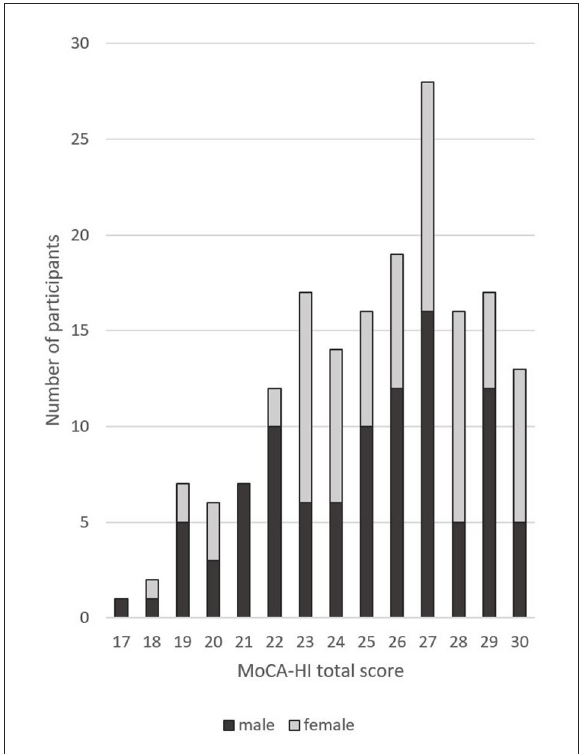
FIGURE2 Distribution of the adjusted MoCA-HI total score.